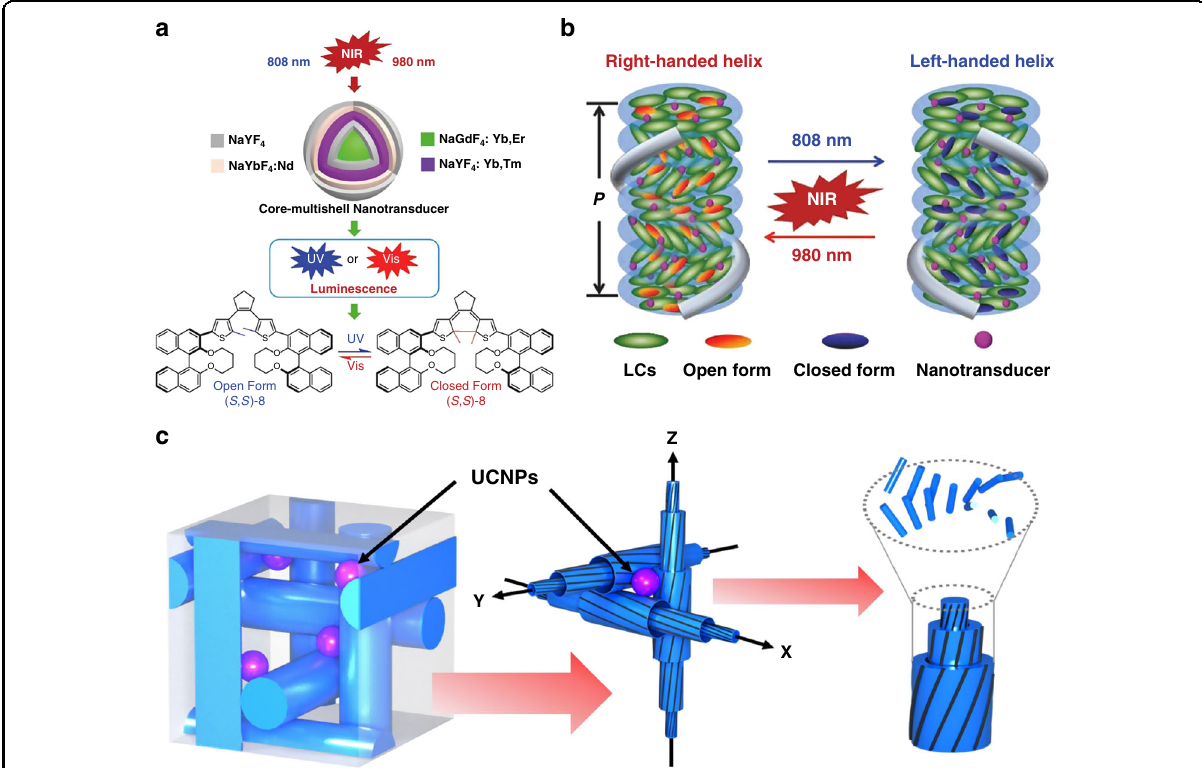
Fig. 13 NIR light-driven chiral liquid crystal nanostructures with UCNPs. a Schematic of NIR light-driven reversible switching of a unique chiral diarylethene with core-multishelled UCNPs. b Schematic demonstration of NIR light-driven handedness inversion of cholesteric superstructures enabled by UCNPs and a chiral diarylethene photoswitch. Reproduced with permission from ref. 309 . Copyright 2015, WILEY-VCH. c Blue-phase 3D nanostructure stabilized by UCNPs. Reproduced with permission from ref. 310 . Copyright 2022,